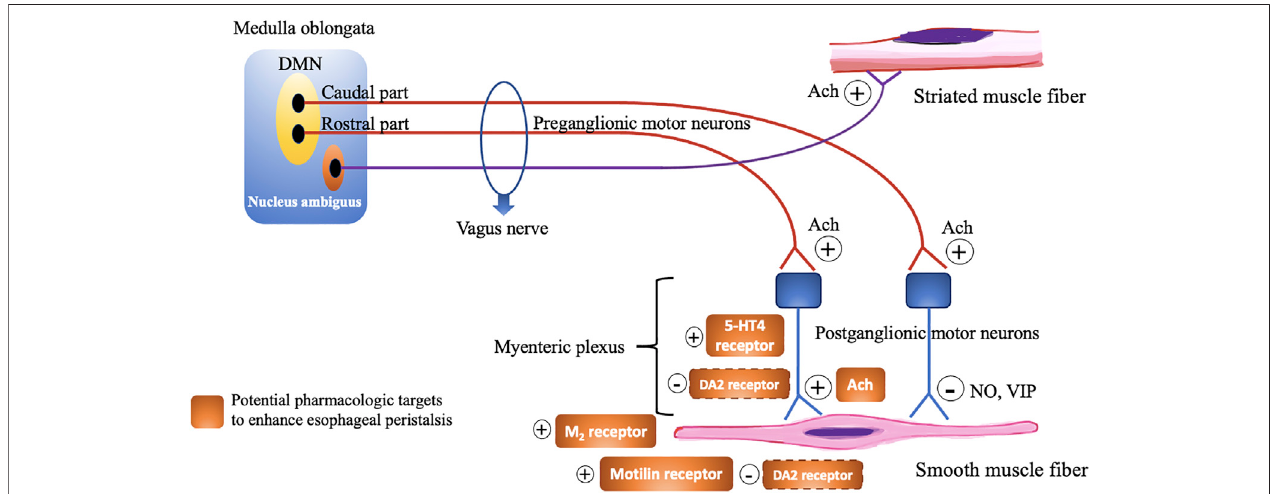
FIGURE 3 | Schematic overview demonstrating the motor innervation of the esophagus and pharmacological targets to enhance esophageal peristalsis. Dashed line signify uncertainty of the exact receptor localization. DMN, Dorsal motor nucleus; Ach, Acetylcholine; NO, Nitric oxide; VIP, Vasoactive intestinal polypeptide; 5-HT, 5-Hydroxytryptamine; M, Muscarinic; DA,